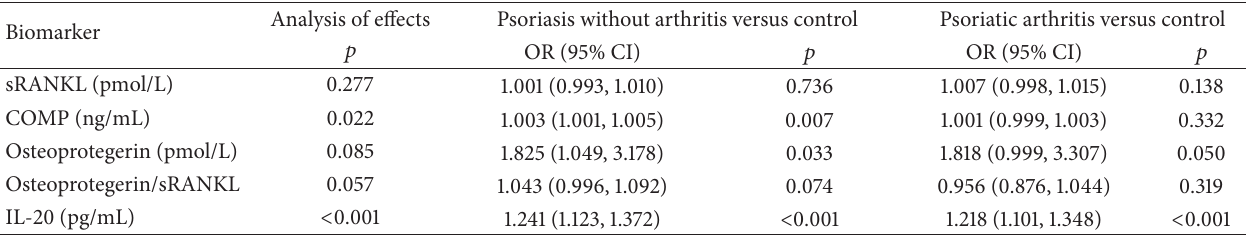
Table 4: Logistic regression analyses of the biomarkers serum concentrations in the psoriasis without arthritis and psoriatic arthritis compared to the control group.